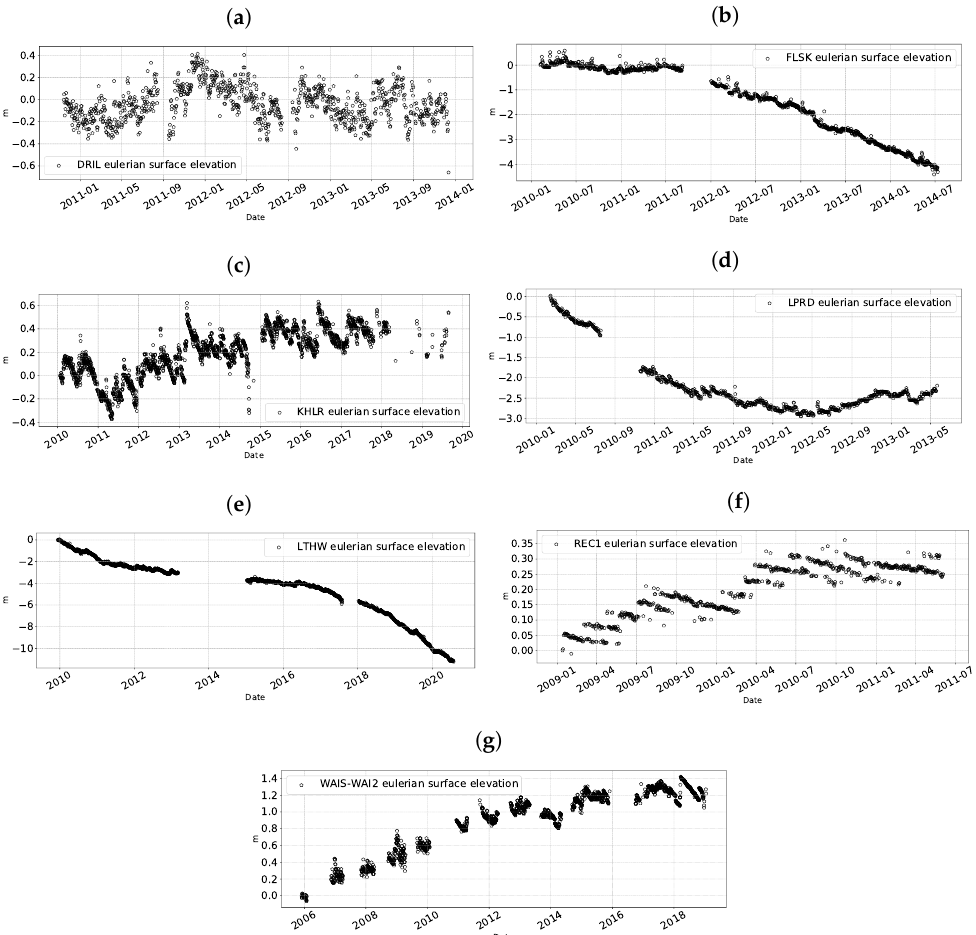
Figure 10. Eulerian surface mean elevation for the eight POLENET antennas considered in this analysis: ( a ) DRIL, ( b ) FLSK, ( c ) KHLR, ( d ) LPRD, ( e ) LTHW, ( f ) REC1, and ( g ) WAIS-WAI2. In 2012, six antennas were active: DRIL, FLSK, KHLR, LPRD, LTHW, and WAIS-WAI2. In Figure 11, we display the 2012 yearly maximum velocity of the Eulerian surface elevation with down going red arrows and up going green arrows. For comparison, the 2019 Eulerian surface elevation velocity for LTHW is reported on the left with an orange arrow. LTHW is the only station for which we have recent data, as KHLR presents too few points in 2019 to perform a linear